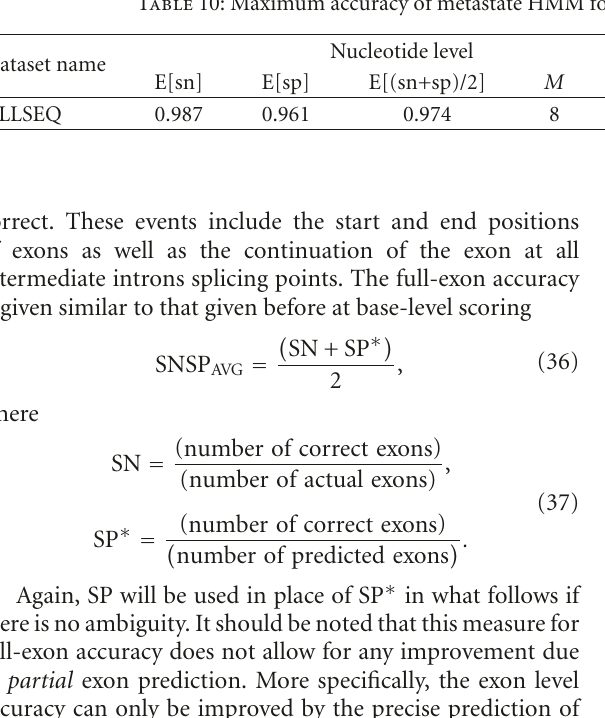
Table 10: Maximum accuracy of metastate HMM for ALLSEQ using the cited method of